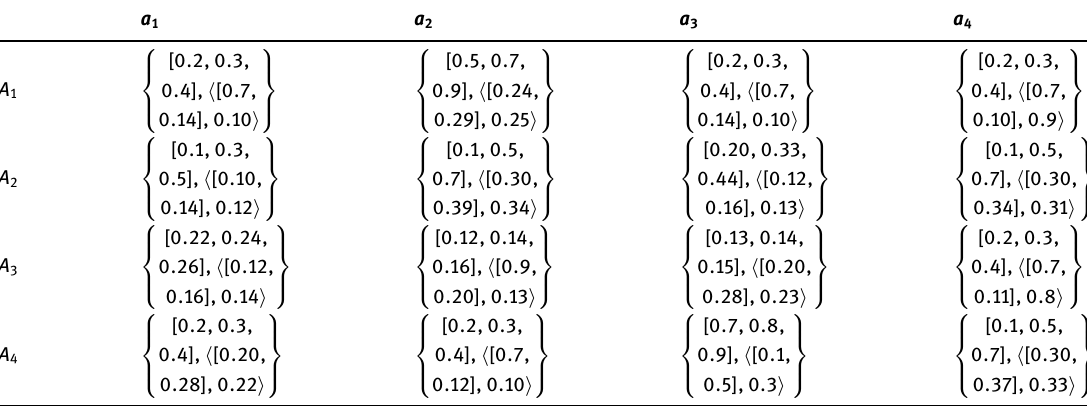
Table 13: Triangular Cubic Fuzzy Decision